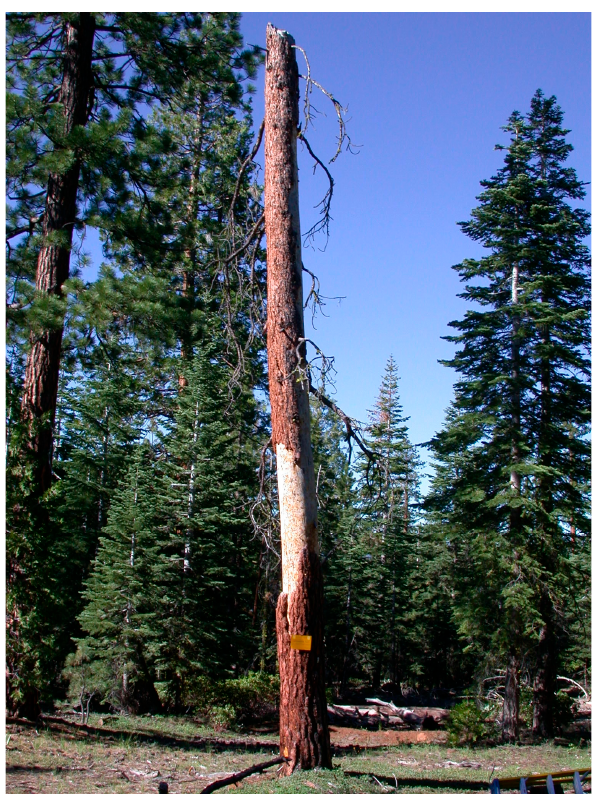
Figure 4. A ponderosa pine ( Pinus ponderosa ) snag created by baiting several years earlier, California. The parental “S-shaped” galleries of western pine beetle ( Dendroctonus brevicomis ) are still partially visible on the bole. Photo credit: C.J. Fe tt ig, USDA Forest Service.